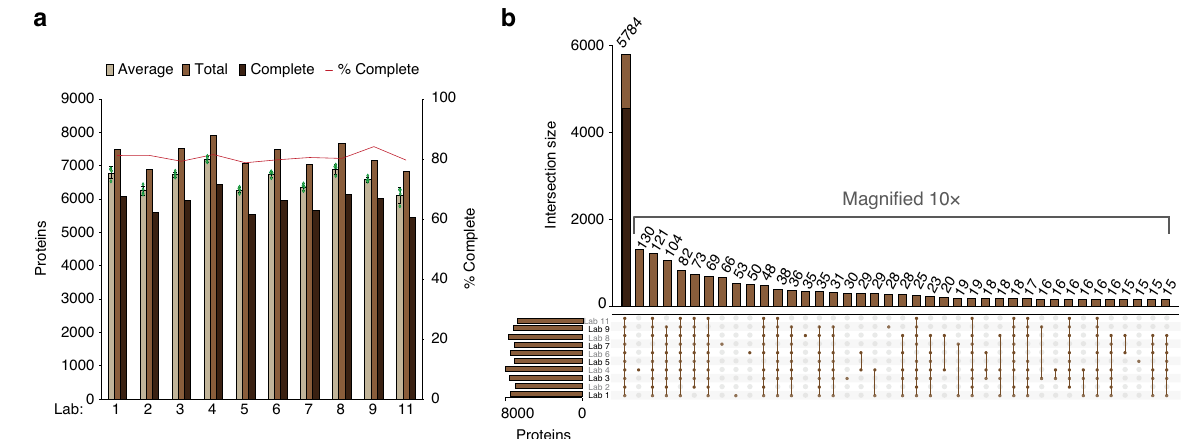
Fig. 4 Reproducibility of quantitative proteome coverage achieved by HRMS-DIA analyses. a The bars depict the number of proteins quanti fi ed in controlled samples at each lab in total (brown), on average (light brown) and consistently (complete, dark brown) across the 7 days evaluation; bars representing average values are plotted together with individual data points in green ( n = 4), corresponding to the four evaluation points sampled every 2 days, and error bars representing + / − SD. The red line shows the percentage of complete pro fi les (Complete/Total). b The numbers of proteins co- quanti fi ed across various combinations of laboratories were plotted (vertical brown bars). The vertical dark brown bar (4565 proteins) overlapping the brown bar (5784 proteins) for the combination including all the laboratories re fl ects the number of proteins co-quanti fi ed by all contributing laboratories at every evaluation day. The horizontal brown bars re fl ect the number of proteins quanti fi ed in total at each laboratory. Source data are provided as a Source Data fi le.